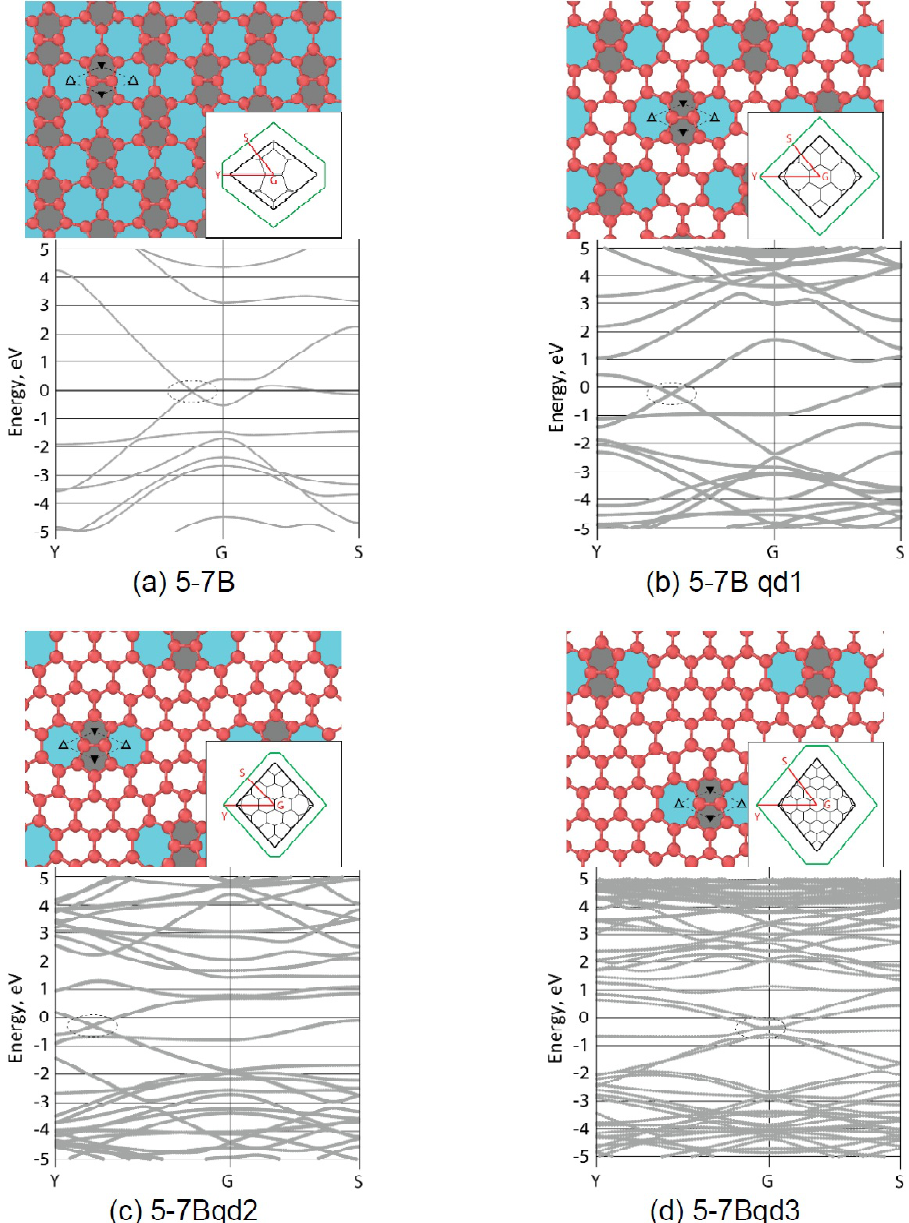
Fig. 6. Pseudo-graphene and graphene with networks consisting of disclination quadrupoles and their band structures. In crystal lattices, the disclination quadrupoles are depicted, and the insets show Brillouin zones. Crystals are marked with 5-7B, 5-7Bqd1, 5-7Bqd2, and 5-7Bqd3. Dirac cones are outlined by dashed ellipses.